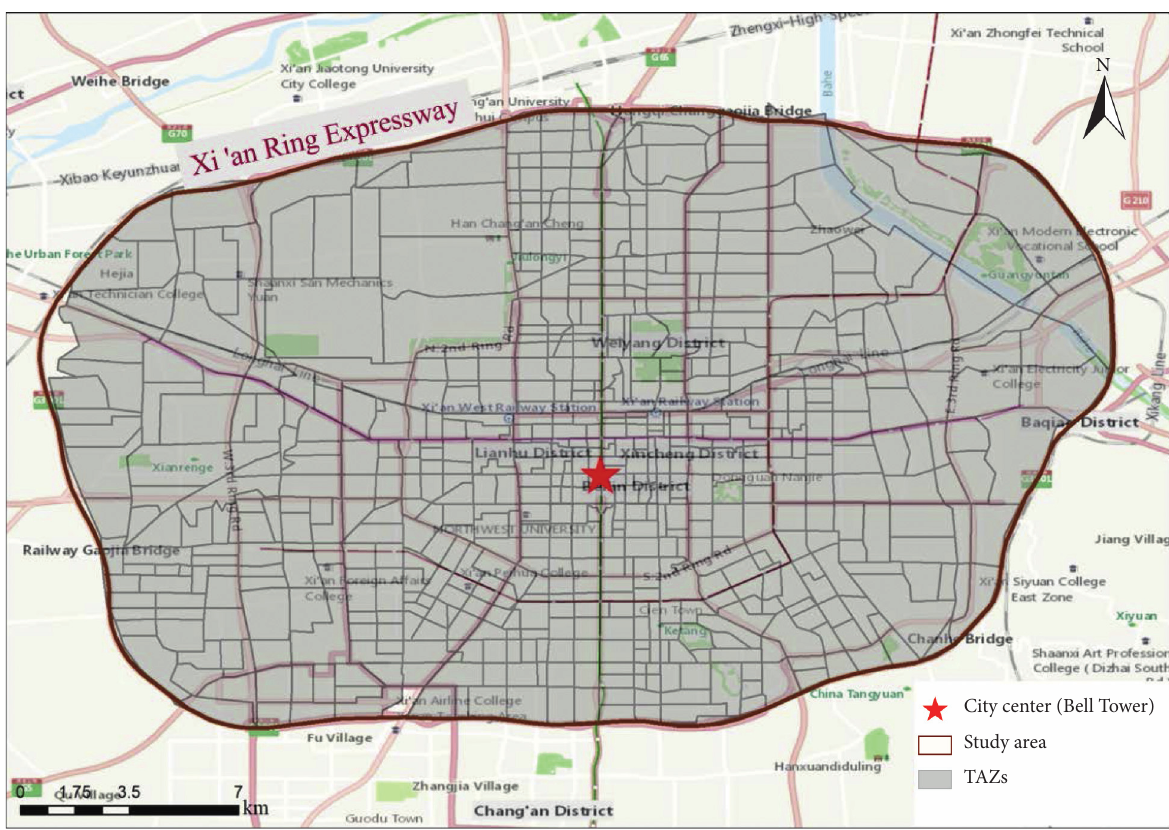
Figure 1: Vehicle restriction areas and study areas.